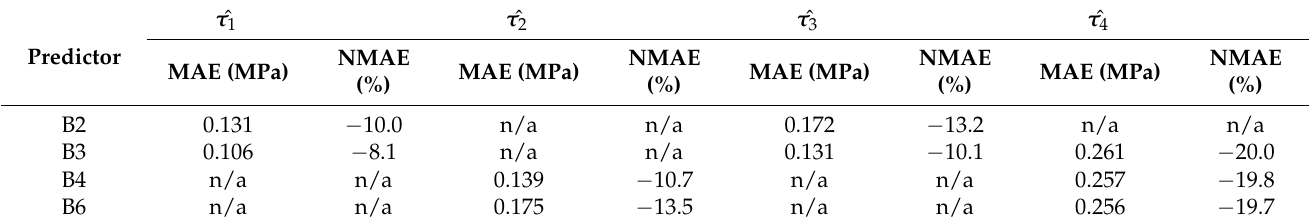
Figure 5. Maps of ˆ Ψ stem for plots N and S based on ˆ τ 1 ( B 3 M ) ( a – d ) and ˆ τ 2 ( B 11 M ) ( e – h ). Maps of percentage differences are also reported ( i – l ). Maps are given for the sampled dates: 23 June ( a , e,i ), 28 July ( b , f , j ), 7 August ( c , g , k ) and 12 August ( d , h , l ). Red dots represent the spatial distribution of surveyed pomegranate plants. The reference system is WGS 84 / UTM 33N, EPSG: 32633. Table 8. Mean absolute errors (MAE) and normalized MAE values, as computed for the best performing models for the τ i estimate (n/a = result not compliant with model performance, i.e., R 2 of the model for τ i estimate <